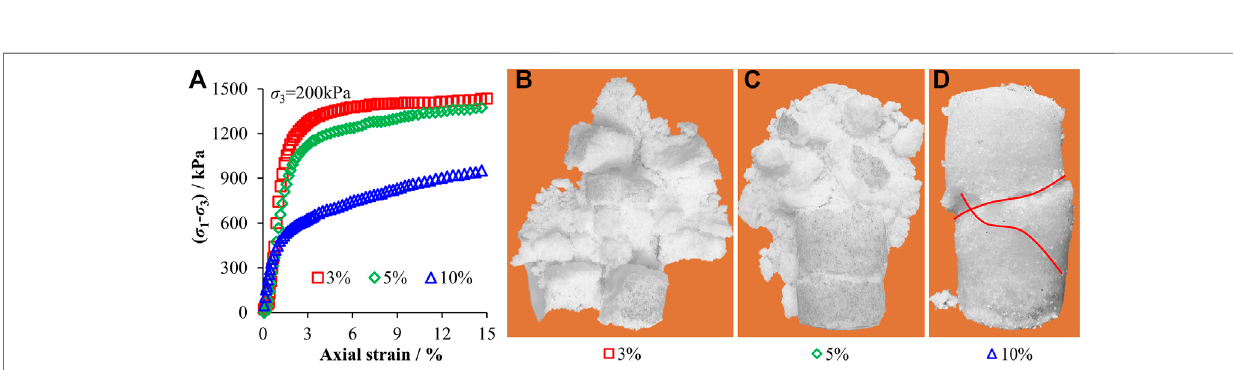
FIGURE13| Stress – strain responses (A) and failure modes ofthe specimens withdifferentmass ratios (separately 3% (B) , 5% (C) , and 10% (D) ) ofsilicapowder.